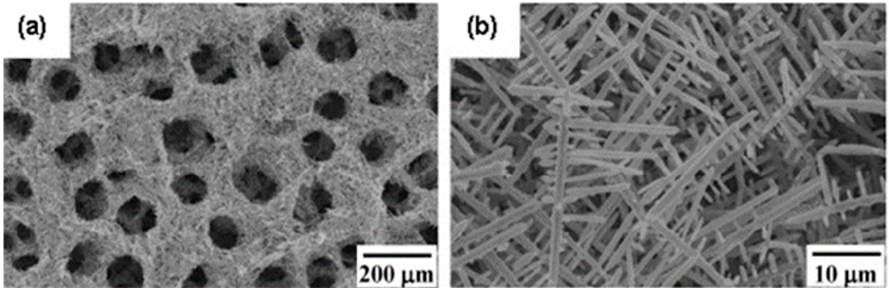
Figure 4. SEM images at two different magnifications ( a ) and ( b ) for Sn foams synthesized from electrochemically deposition after 15 s. Reproduced from Ref. [78] with permission from Elsevier, 2012.